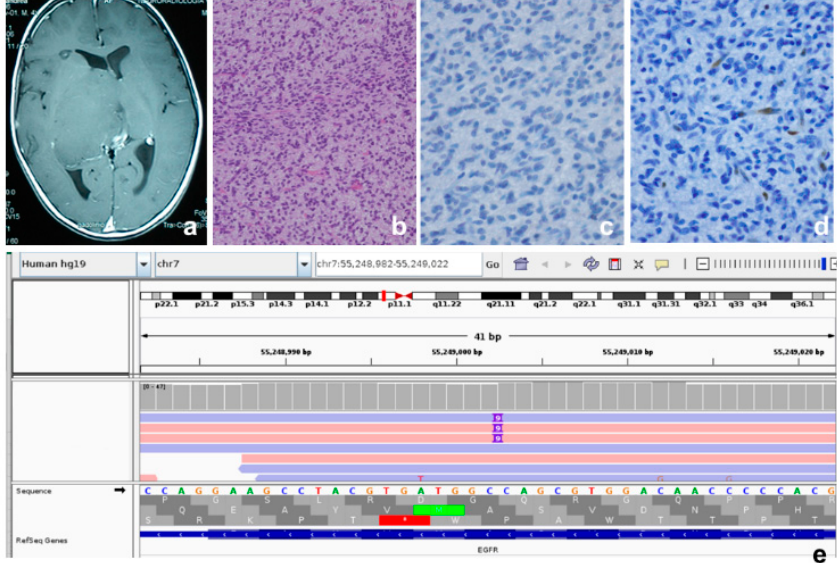
Figure 2. Patient P4, thalamic diffuse EGFR mutant pHGG: ( a ) T2-weighted image, presence of hyperintense mass in the right thalamic area. The tumor is in contact with the medial portion of the third ventricle and the occipital horns. No development of hydrocephalus; ( b ) spindle-shaped atypical cells, hematoxylin and eosin, original magnification 20 × ; ( c ) negative nuclear staining for H3.3K27M-mutant protein, original magnification 20 × ; ( d ) negative nuclear staining for H3.3K27me3 in tumor cells and positive control in the endothelial cells, original magnification 20 × ; ( e ) the variant c.2300_2301insCAGCGTGGA p.Ala767_Ser768insAlaTrpThr in exon 20 of the EGFR gene (NM_005228) is read in both the strands 42X.